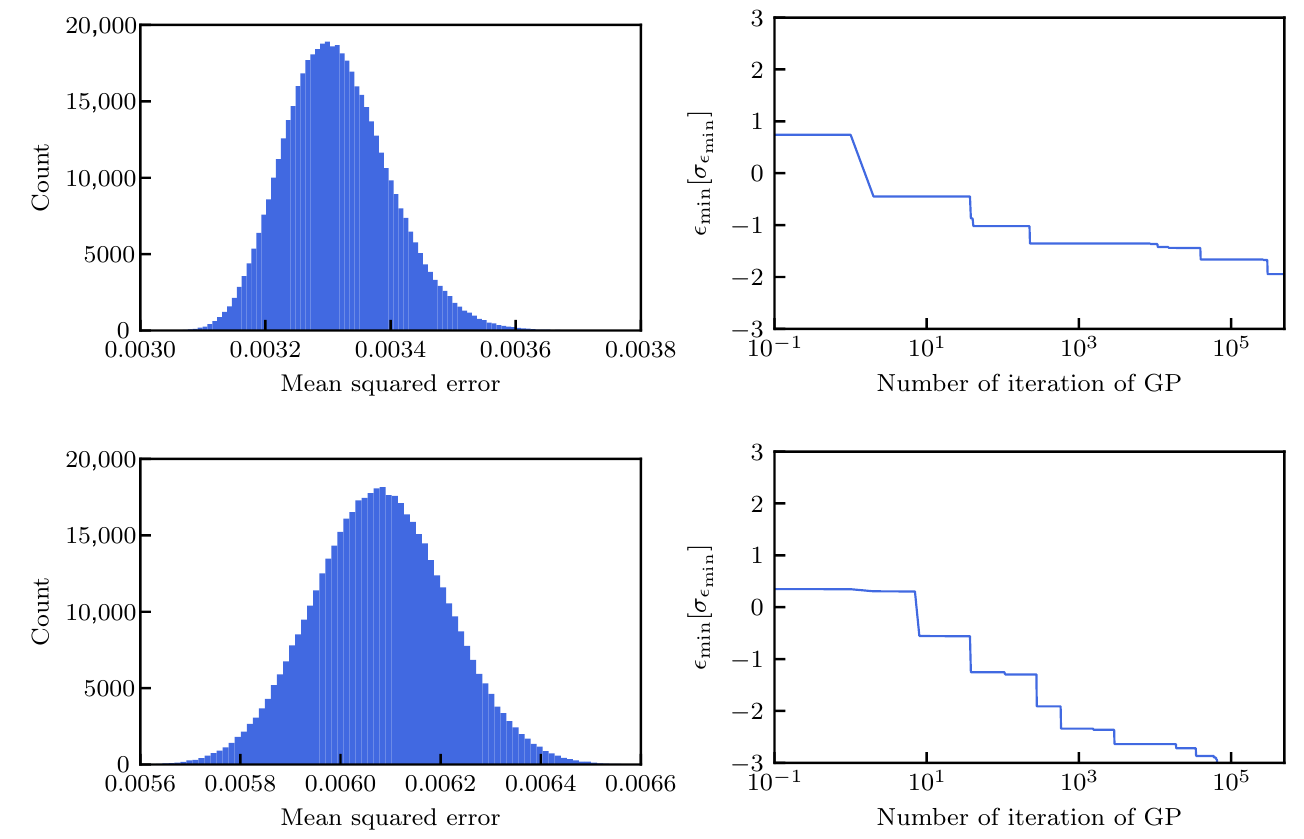
Figure 9. ( Top row ): Distribution of the MSE for the fit of the DA model (14b) with three parameters, after applying a GP to the DA numerical data 5 × 10 5 times ( left ) and evolution of (cid:101) min as a function of the number of iterations of the GP ( right ). ( Bottom row ): Same, but for the model with two